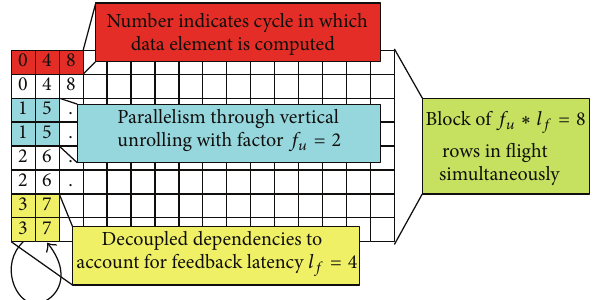
Figure 7: Illustration of compute order for horizontal sums on Maxeler. Here, an unrolling factor 𝑓 𝑢 = 2 and a feedback latency 𝑙 𝑓 are illustrated.